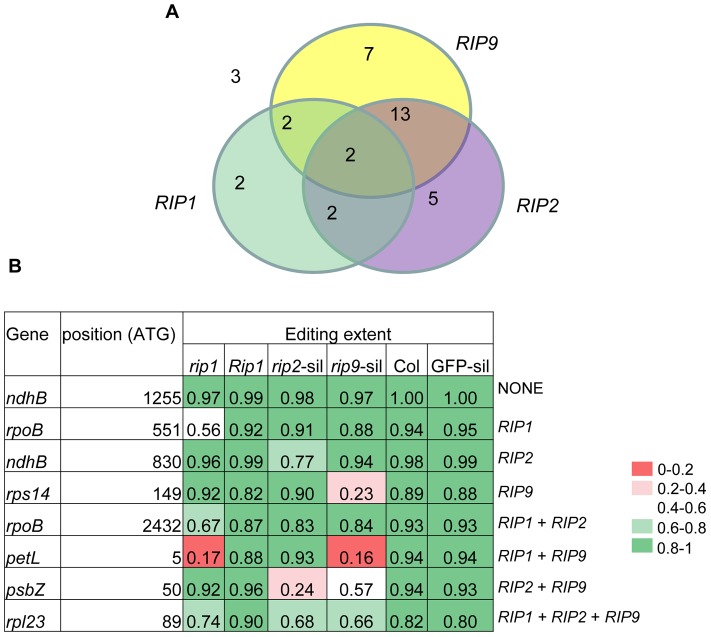
Relative importance of RIPs on plastid editing.(A) Number of plastid sites under the control of RIPs (ΔEE≥0.1, P 2.7<10−5). RIP2 and RIP9 results were obtained from VIGS. (B) Examples of plastid sites falling into one of the eight categories described in the Venn diagram shown in (A). The background color reflects the range of editing extent from red (low: 0–0.2) to dark green (high: 0.8–1).